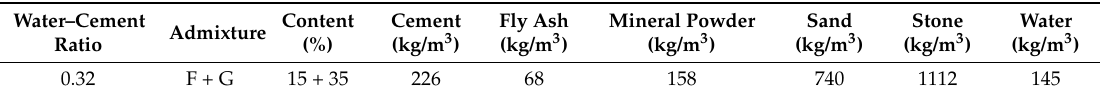
Table 1. Mix ratio of